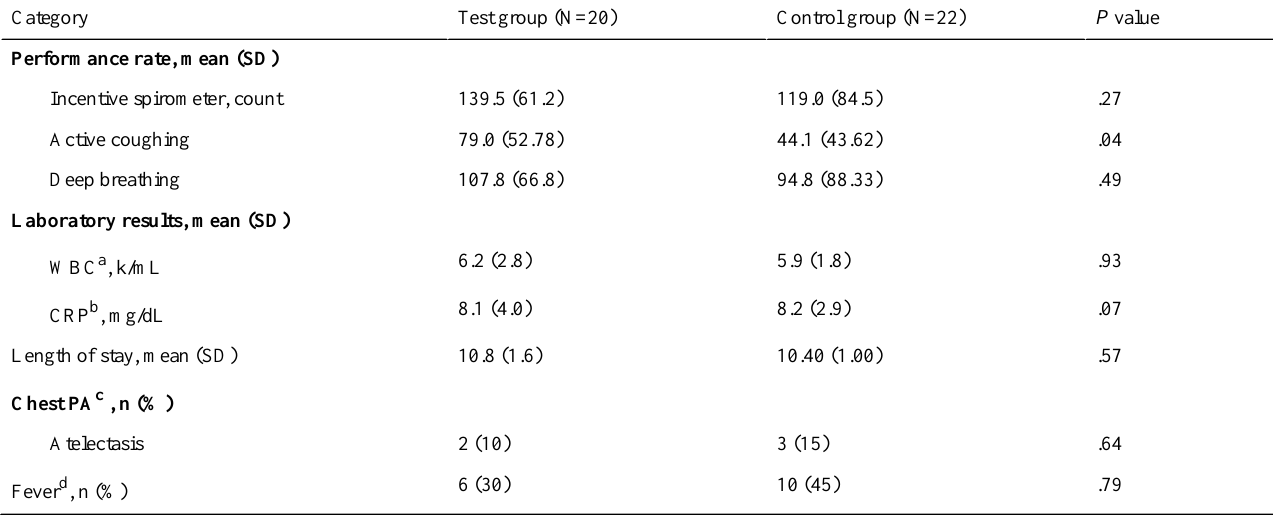
Table 3. Other outcomes.